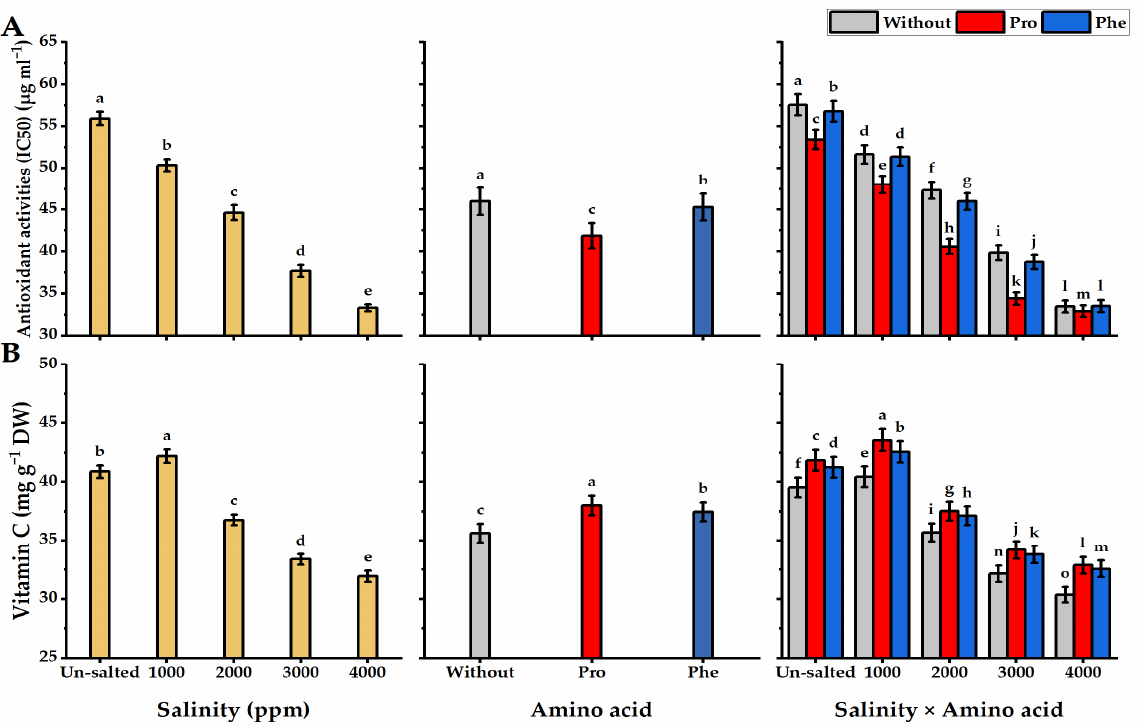
Figure 7. Influence of exogenous spray treatments of proline (Pro) or phenylalanine (Phe) on ( A ) antioxidant activity and ( B ) vitamin C of moringa trees cultivated under different levels of salinity. Data are mean value ± SE. Bars with different letters are significantly different at p ≤ 0.05 level .